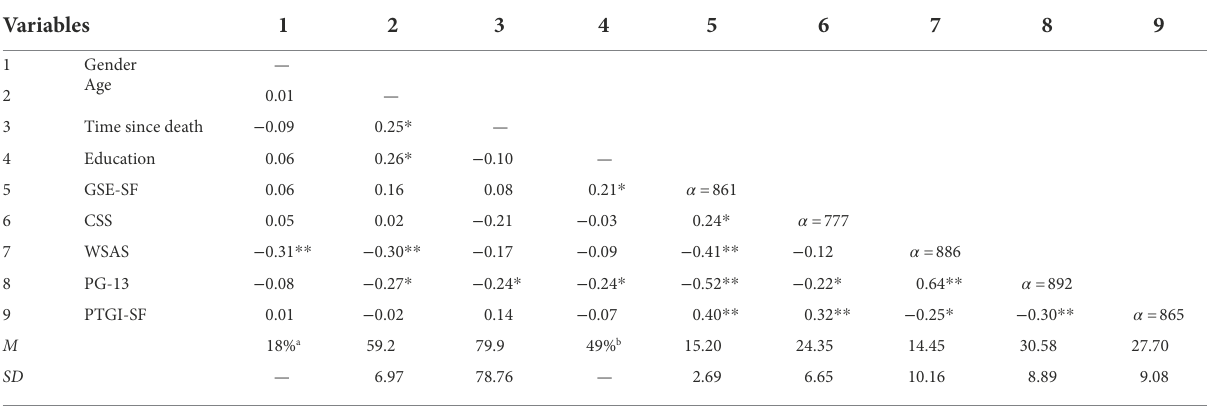
TABLE 3 Mean (SD), internal consistency estimates, and inter-correlations for all study variables ( n = 89).